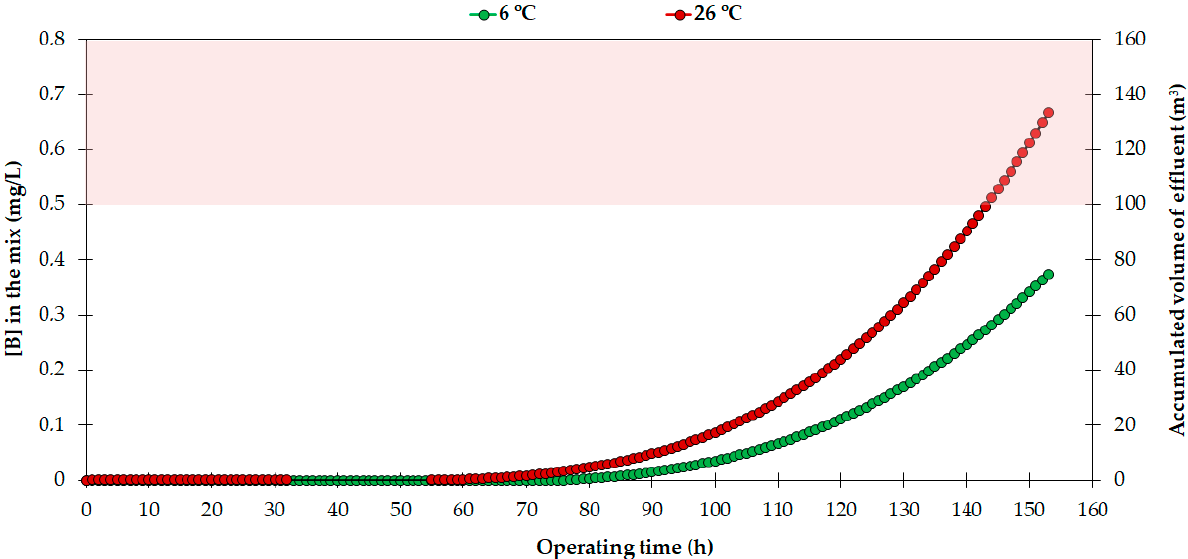
Figure 7. Boron concentration in a theoretical effluent-regulator reservoir. The shaded area represents the phytotoxicity threshold of woody crops.